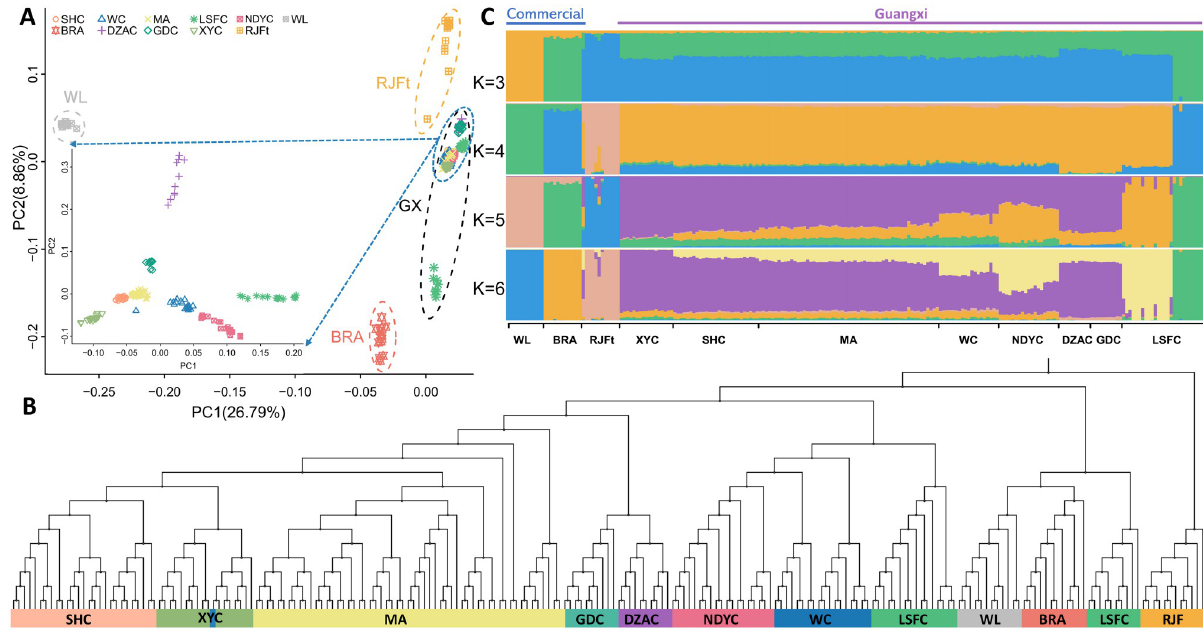
Fig 3. Population structure analyses. (A) Principal component analysis (PCA), with 26.79% and 8.86% variance explained in PC1 and PC2, respectively. (B) Neighbor-joining tree of 221 chickens, constructed with PHYLIPNEW version 3.69.650. (C) Admixture analysis with K values running from 3 to